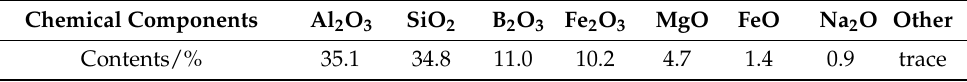
Table 2. The chemical composition of TAP.